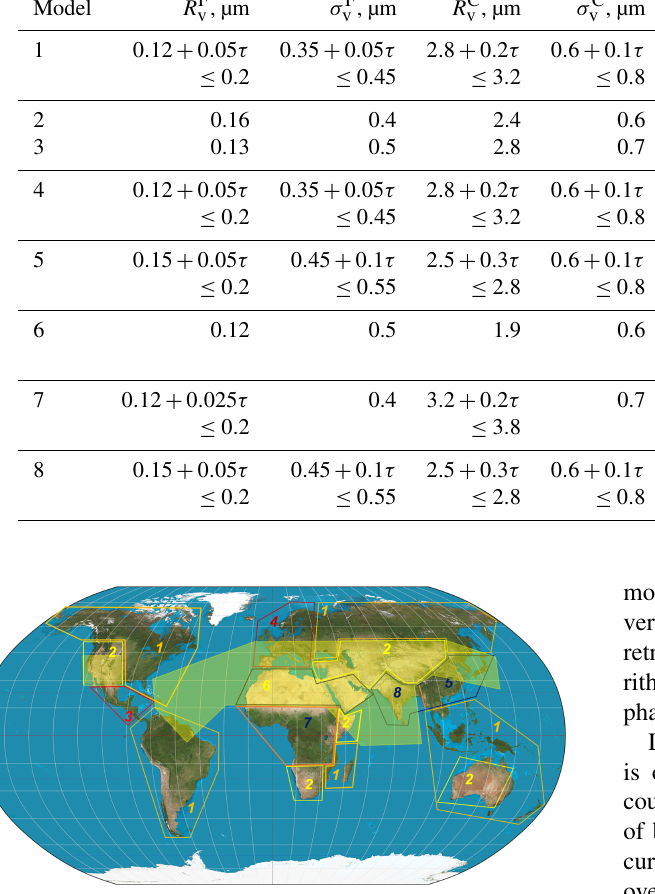
Figure 4. Map of background regional aerosol models specified in Table 1. The transparent yellow shape approximates the dust re-